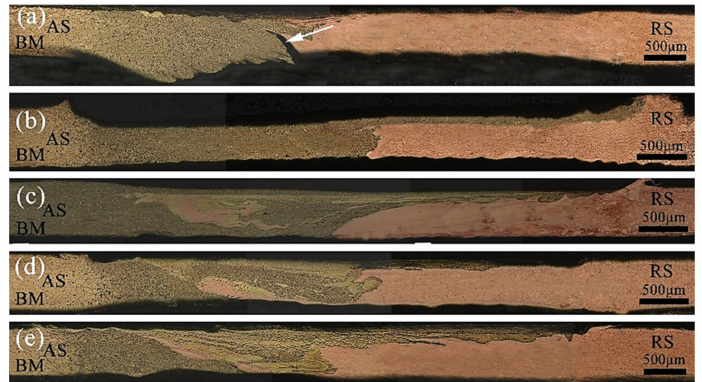
Figure 5. Micromorphology of H62 / T2 joints under di ff erent welding speeds of 240 mm / min: ( a ) 10,000 rpm, ( b ) 11,000 rpm, ( c ) 12,000 rpm, ( d ) 13,000 rpm, ( e ) 14,000 rpm.